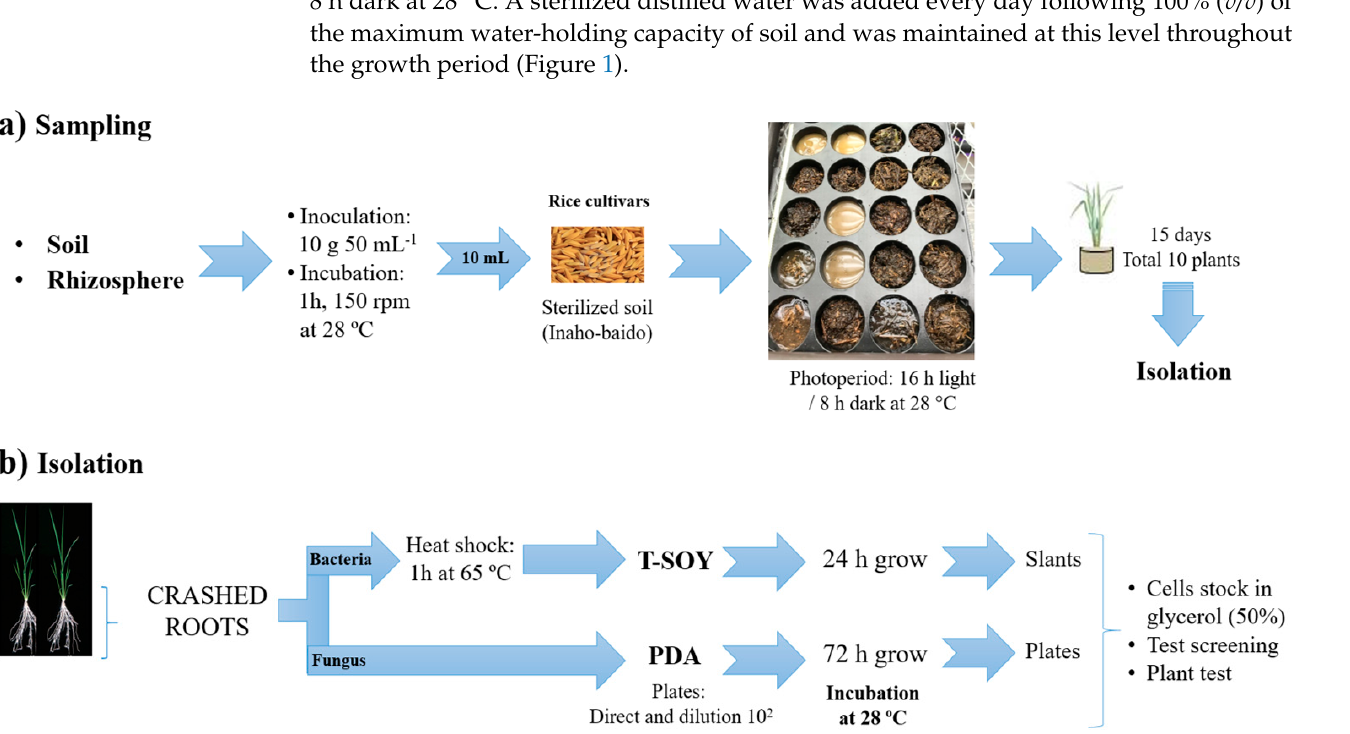
Figure 1. Spore-forming microbes (SFM) isolation from Fukushima prefecture, Japan. ( a ) Inoculation with rhizosphere and soil into Oryza sativa L. ( b ) SFM isolation from rice roots. (T-soy: Trypticase soy agar. PDA: Potato dextrose agar).